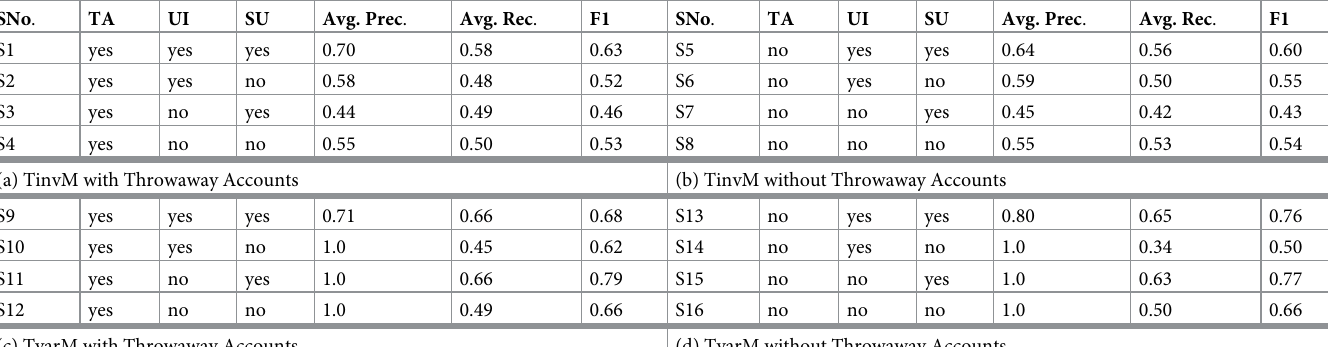
(d) TvarM without Throwaway Accounts